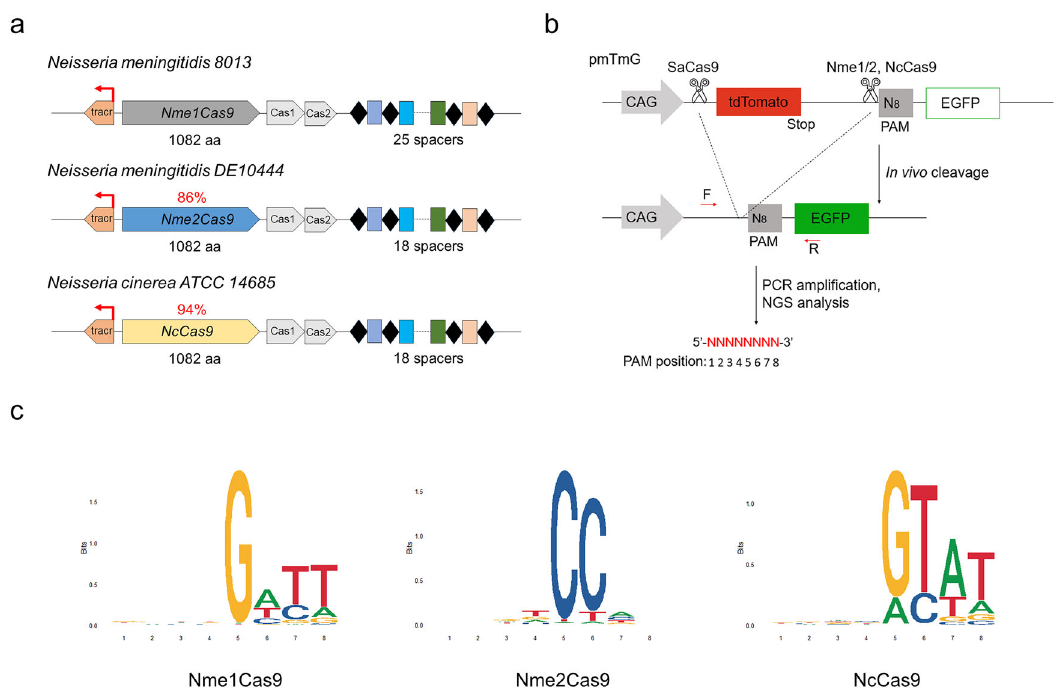
Fig. 1 PAM identi fi cation by PAM-DOSE. a Schematic showing the CRISPR/Cas loci of the strains encoding the Nme1Cas9, Nme2Cas9, and NcCas9 orthologs. Red arrows denote tracrRNA transcription initiation sites. Percent identities of Nme2Cas9 and NcCas9 with Nme1Cas9 are 86% and 94%, respectively. b Schematic showing the PAM-DOSE assay for characterization of PAM sequences recognized by Cas9s. An 8 N library of PAM sequences were introduced into the constructs. In the presence of a functional PAM, cleavage-mediated tdTomato cassette excision was performed, which led to the expression of EGFP. After Cas9 cleavage, cleaved products were PCR ampli fi ed and subjected to deep sequencing to identify PAM sequences. c The sequence logo showing the PAM speci fi city of Nme1Cas9, Nme2Cas9, and NcCas9 was obtained using deep-sequencing data.